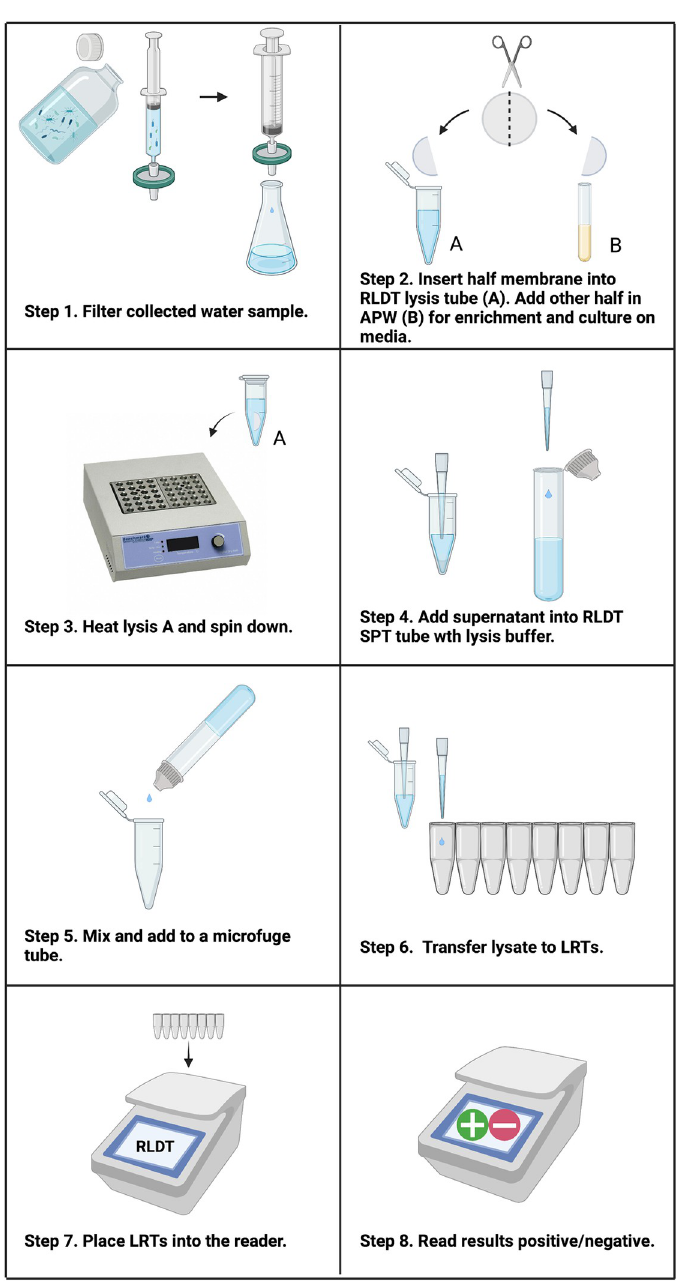
Fig 2. Workflow of cholera RLDT from water samples. Step 1, Filter 400ml water using a syringe filter. Step 2, cut membrane in half and insert one half in the lysis tube (A). Place the other half in APW media (B) for